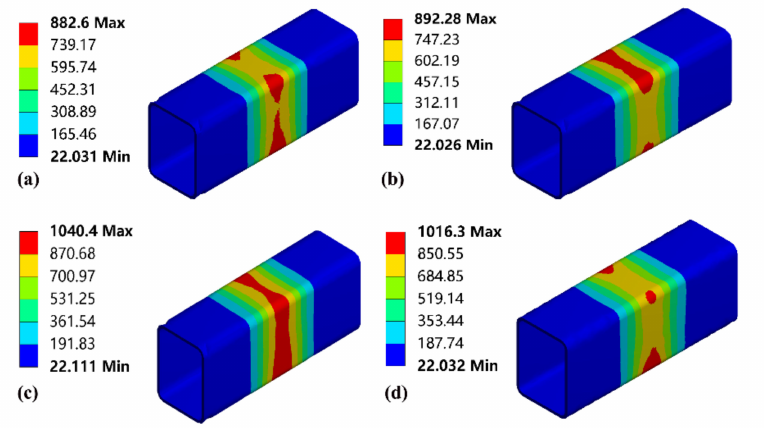
Figure 11. The temperature distributions of a rectangular steel tube based on different inductor structures: ( a ) the inductor with the structure a; ( b ) the inductor with the structure b; ( c ) the inductor with the structure c; ( d ) the inductor with the structure